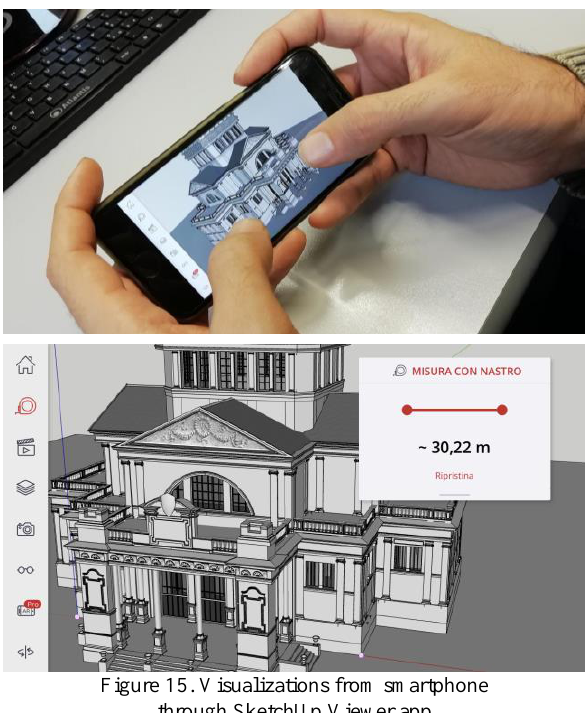
Figure 15. Visualizations from smartphone through SketchUp Viewer